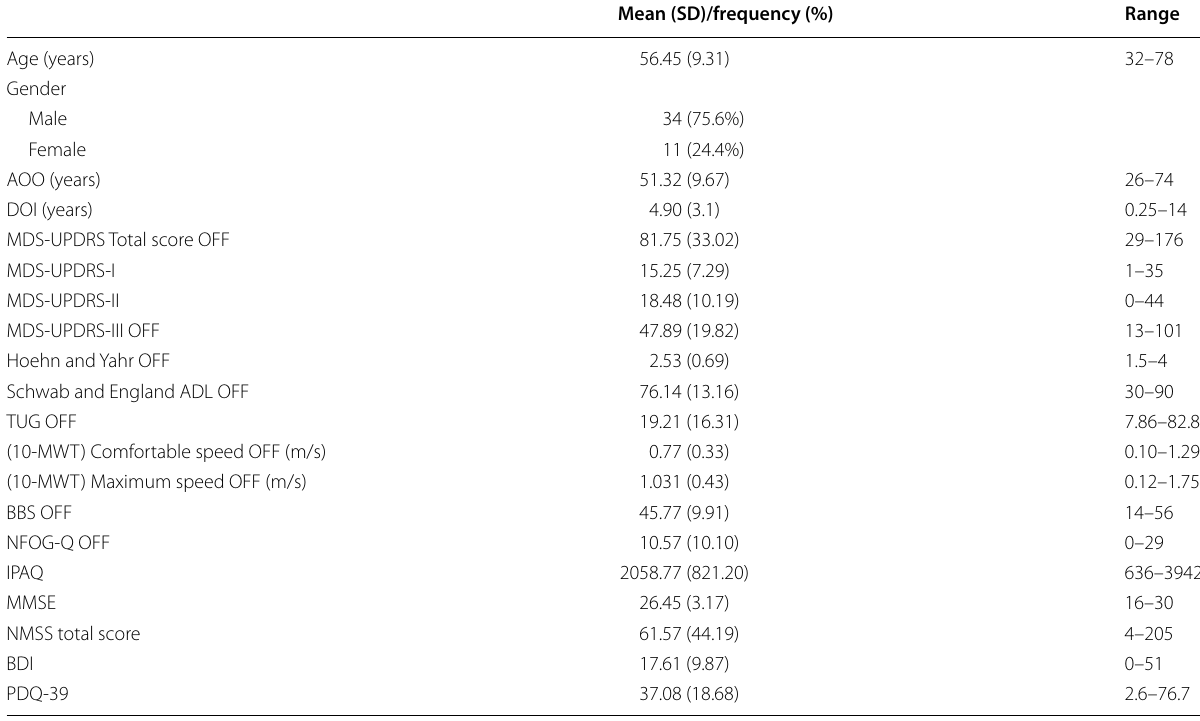
Table 1 Baseline demographic data and clinical characteristics of PD